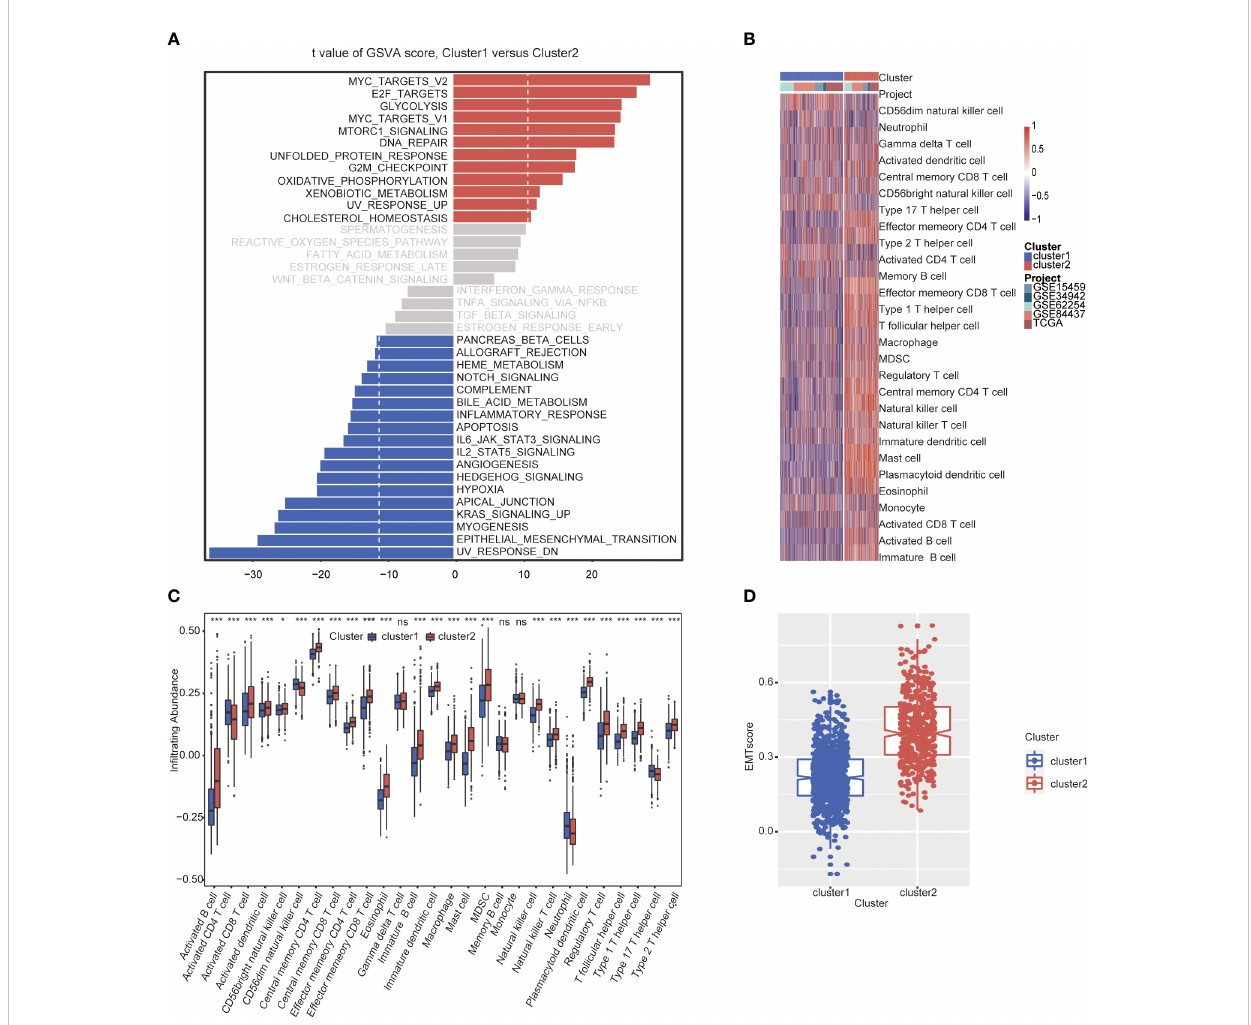
FIGURE 3 Molecular and immune characteristic analysis between two autophagy subtypes. (A) Differential expression of genes in GC patients between cluster 1 and cluster 2 was analyzed by GSVA. (B) Heatmap of the two clusters based on autophagy-related genes expression for 21 immune terms. (C) Box plots to visualize signi fi cantly different immune cells between two clusters. (D) Box plots shows that EMT score of cluster 1 is higher than cluster 2 (P<0.001) (*P< 0.05; ***P< 0.001; NS or ns, P >